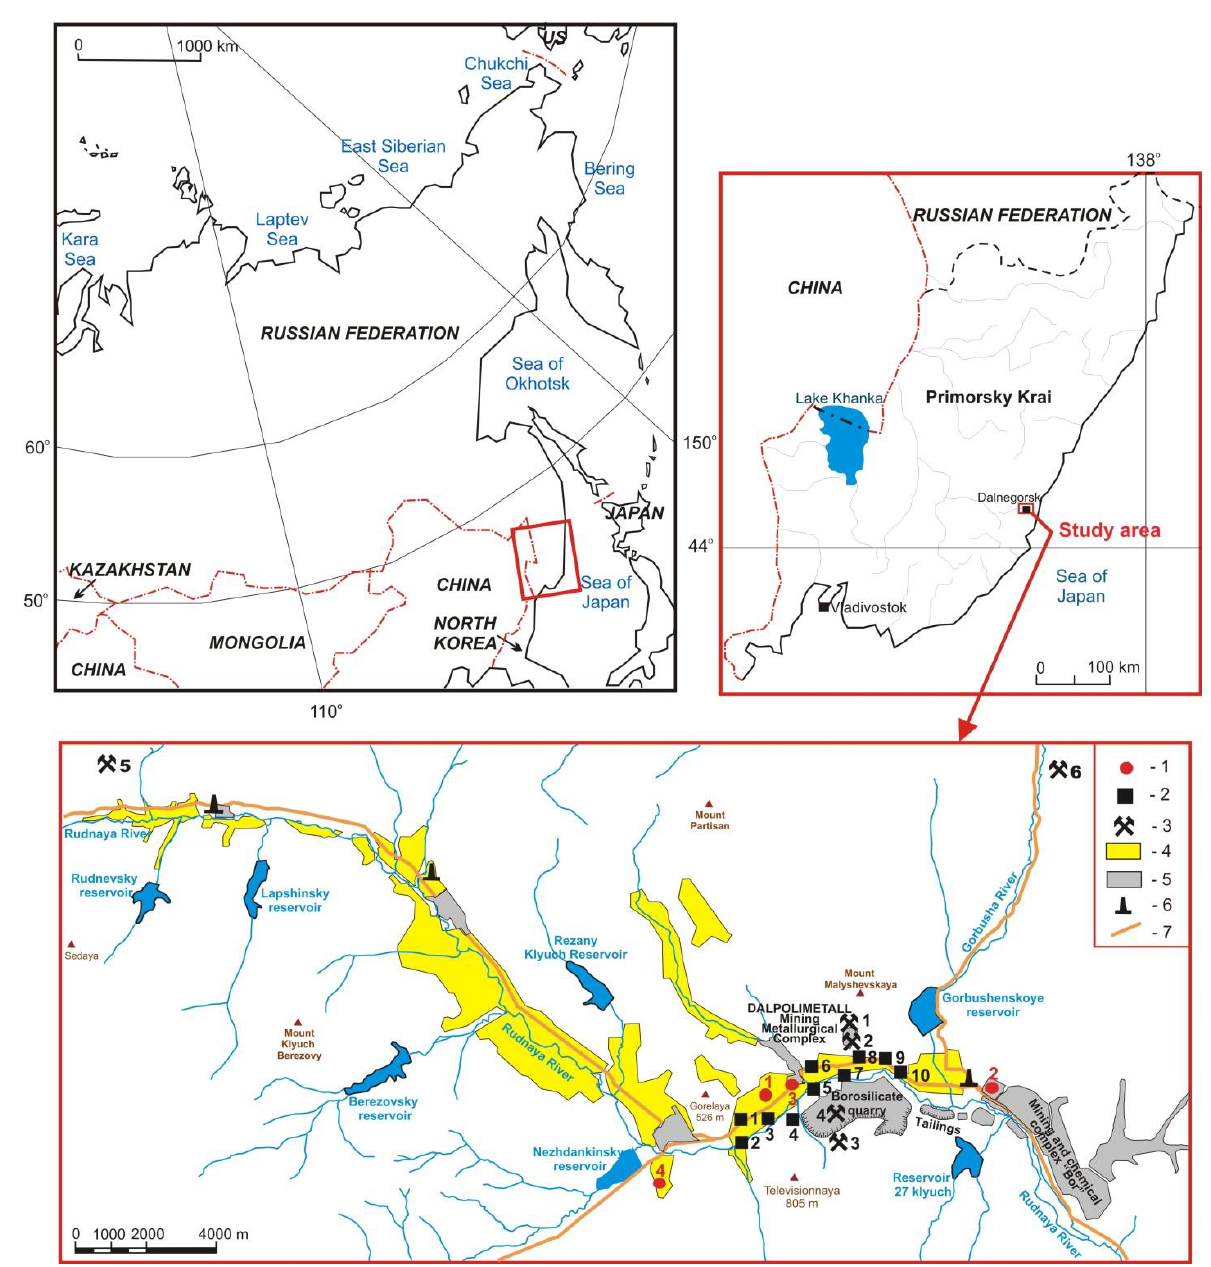
Figure 1. The study area and locations of vegetation (1) and snow sampling points (2); deposits under exploitation (3): 1, Nikolayevskoye; 2, Verkhneye; 3, Partizanskoye; 4, Dalnegogorskoye borosilicate; 5, Yuzhnoye; 6, Mayminovskoye; residential area (4); industrial area (5); boiler houses (6); regional highway (7).